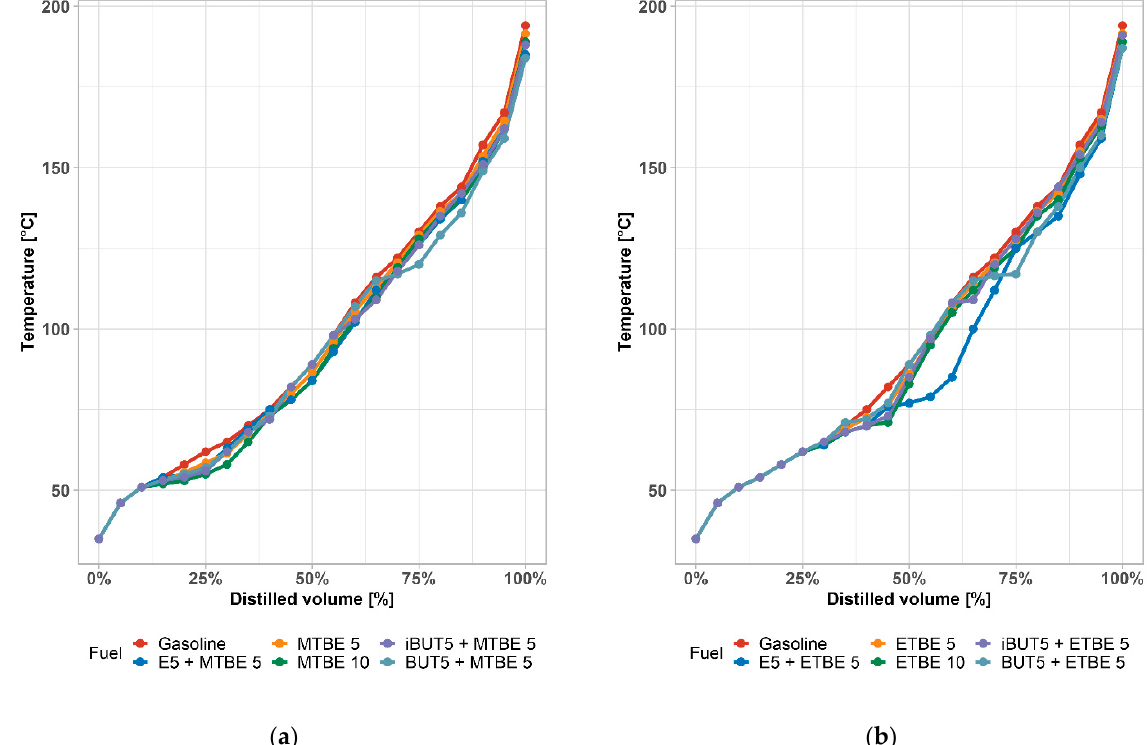
Figure 4. ( a ) Distillation curves of gasoline containing ethanol, n–butanol, and i–butanol with Methyl tert-butyl ether (MTBE); ( b ) distillation curves of gasoline containing ethanol, n–butanol, and i–butanol with ethyl tert-butyl ether (ETBE).